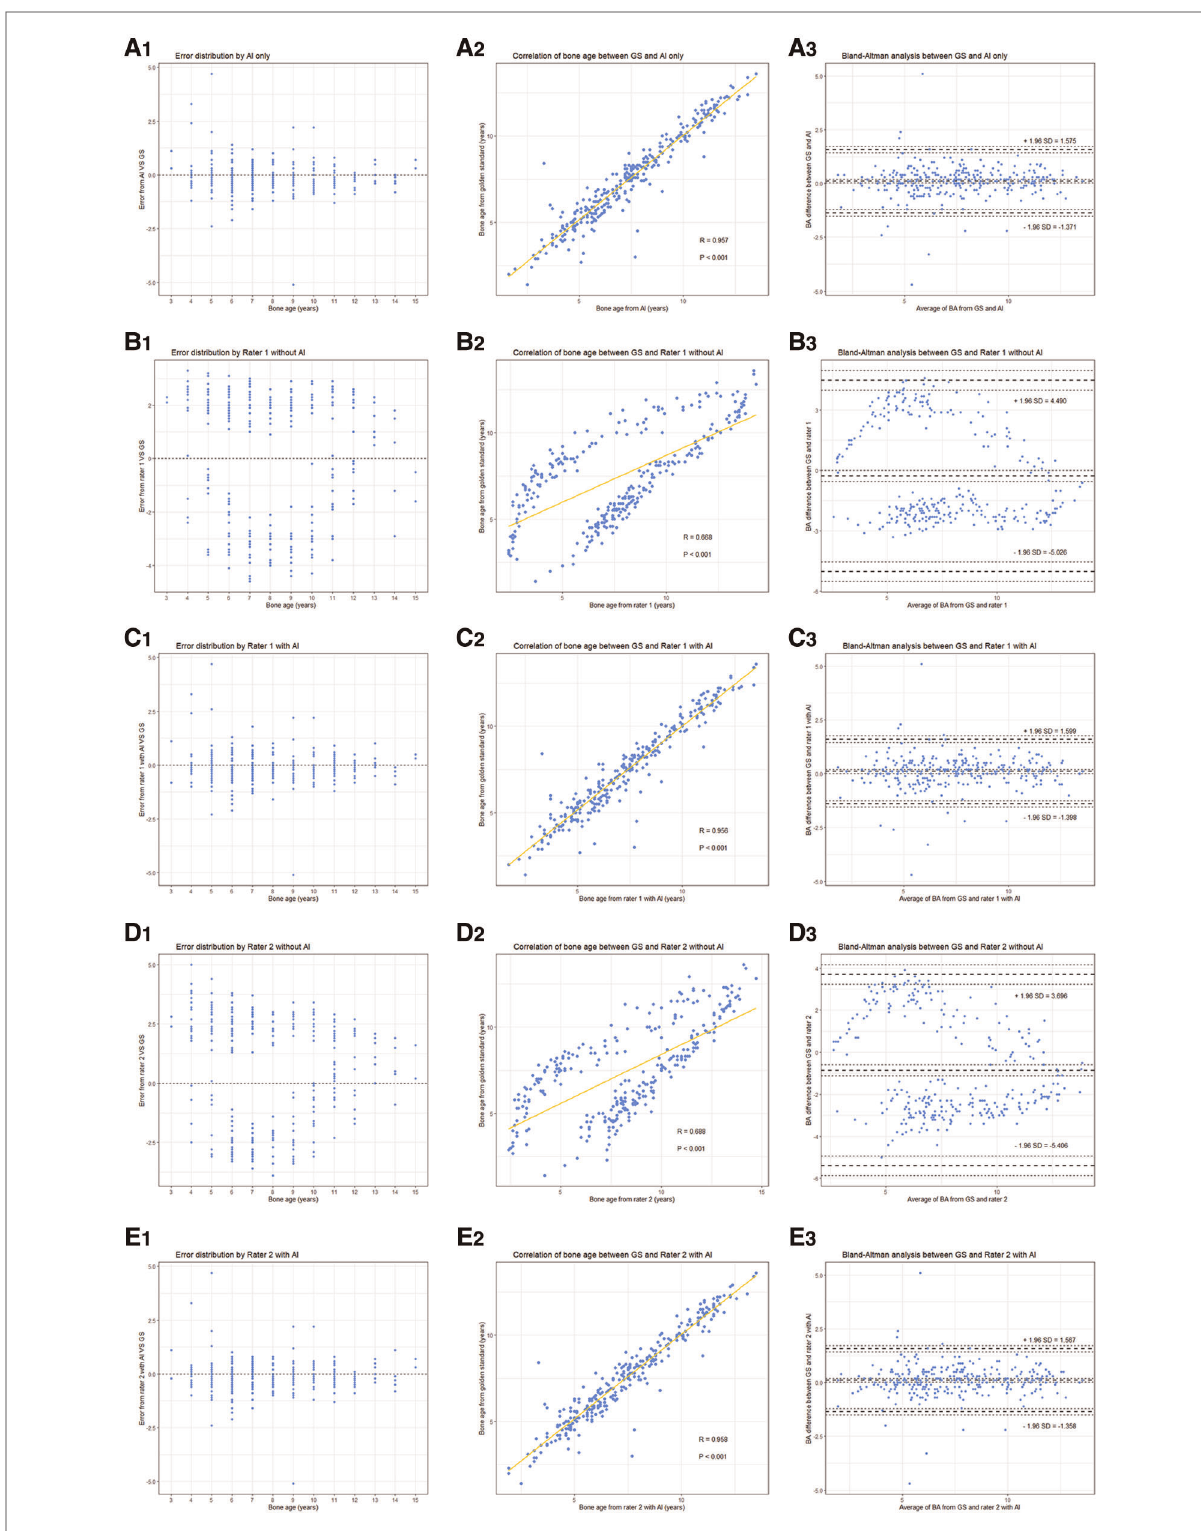
FIGURE 3 Performance of different raters in BA assessment. (left to right) Each column represents error distribution, correlation coef fi cient, and Bland-Altman analysis (95% LoA, limits of agreement), respectively. From top to bottom, i.e., ( A – E ) are the results performed by AI and the two junior raters (with or without AI